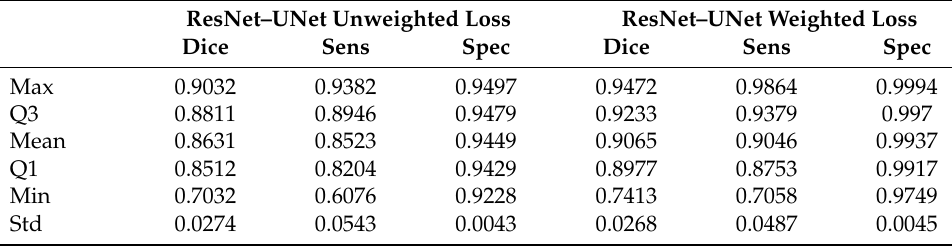
Figure 14. Comparison of ResNet–UNet network trained with unweighted Dice loss and weighted Dice loss. Table 1. Results of the ResNet–UNet trained with unweighted and weighted Dice